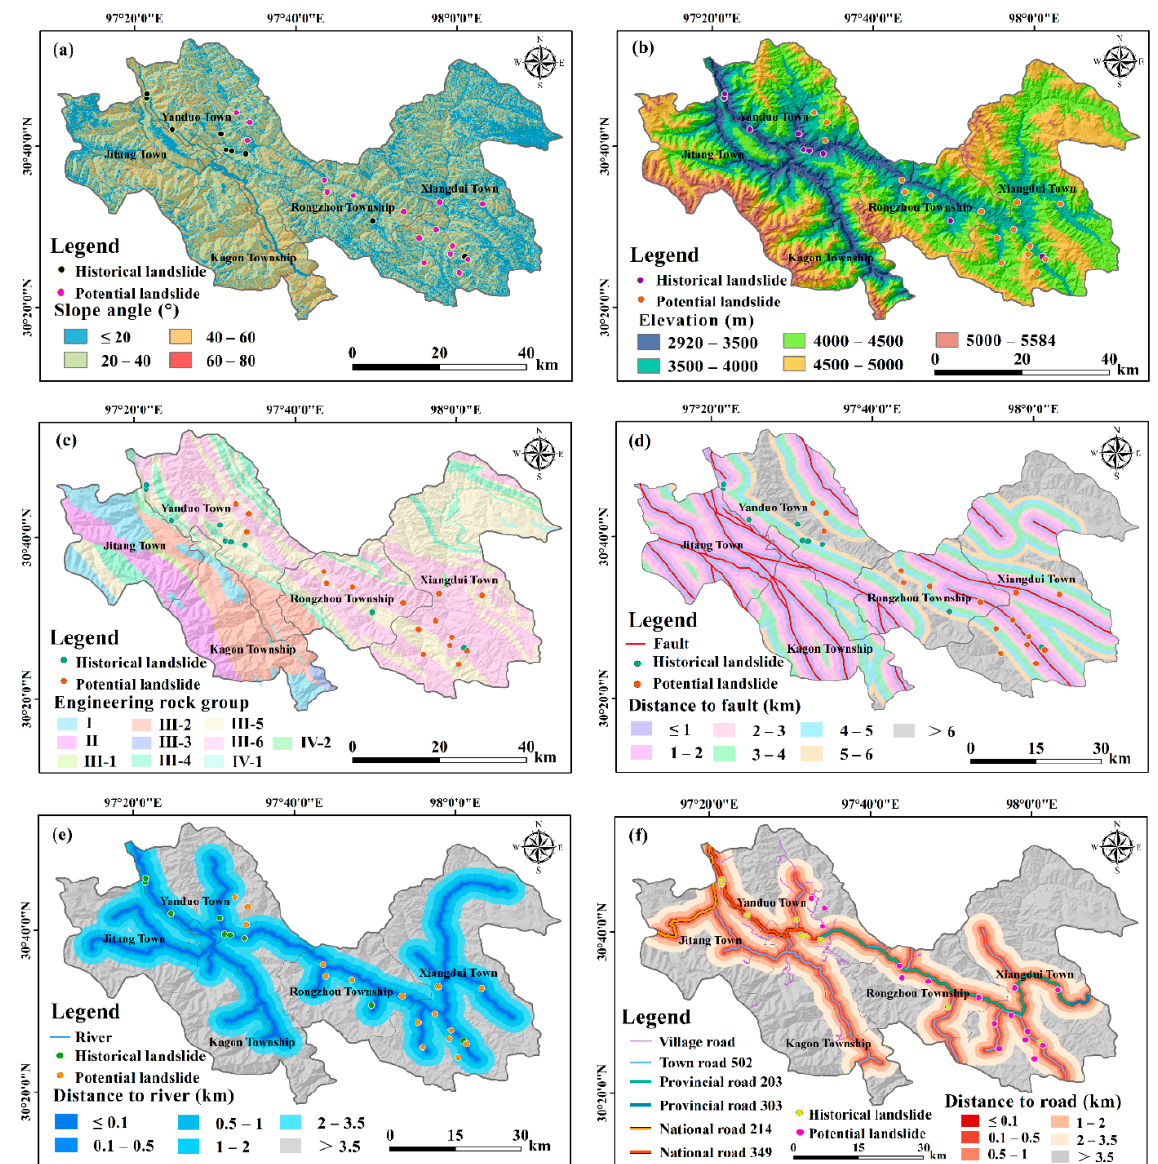
Figure 13. Disaster-controlling and disaster-triggering characteristics of active landslides. ( a ) Relation between active landslide distribution and slope angles. ( b ) Link between active landslide distribution and elevations. ( c ) Distribution of active landslides on engineering rock groups. ( d ) Distance from active landslides to faults. ( e ) Distance from active landslides to rivers. ( f ) Distance from active landslides to roads. See Table 2 for the meaning of engineering rock groups.